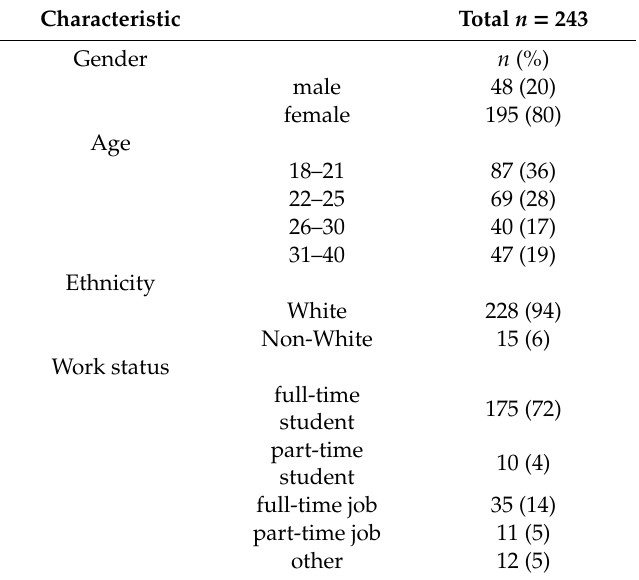
Table 1. Participants’ Sociodemographic